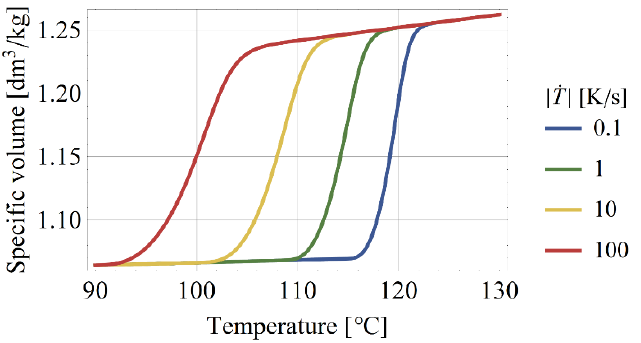
Figure 3. Specific volume at atmospheric pressure for different cooling